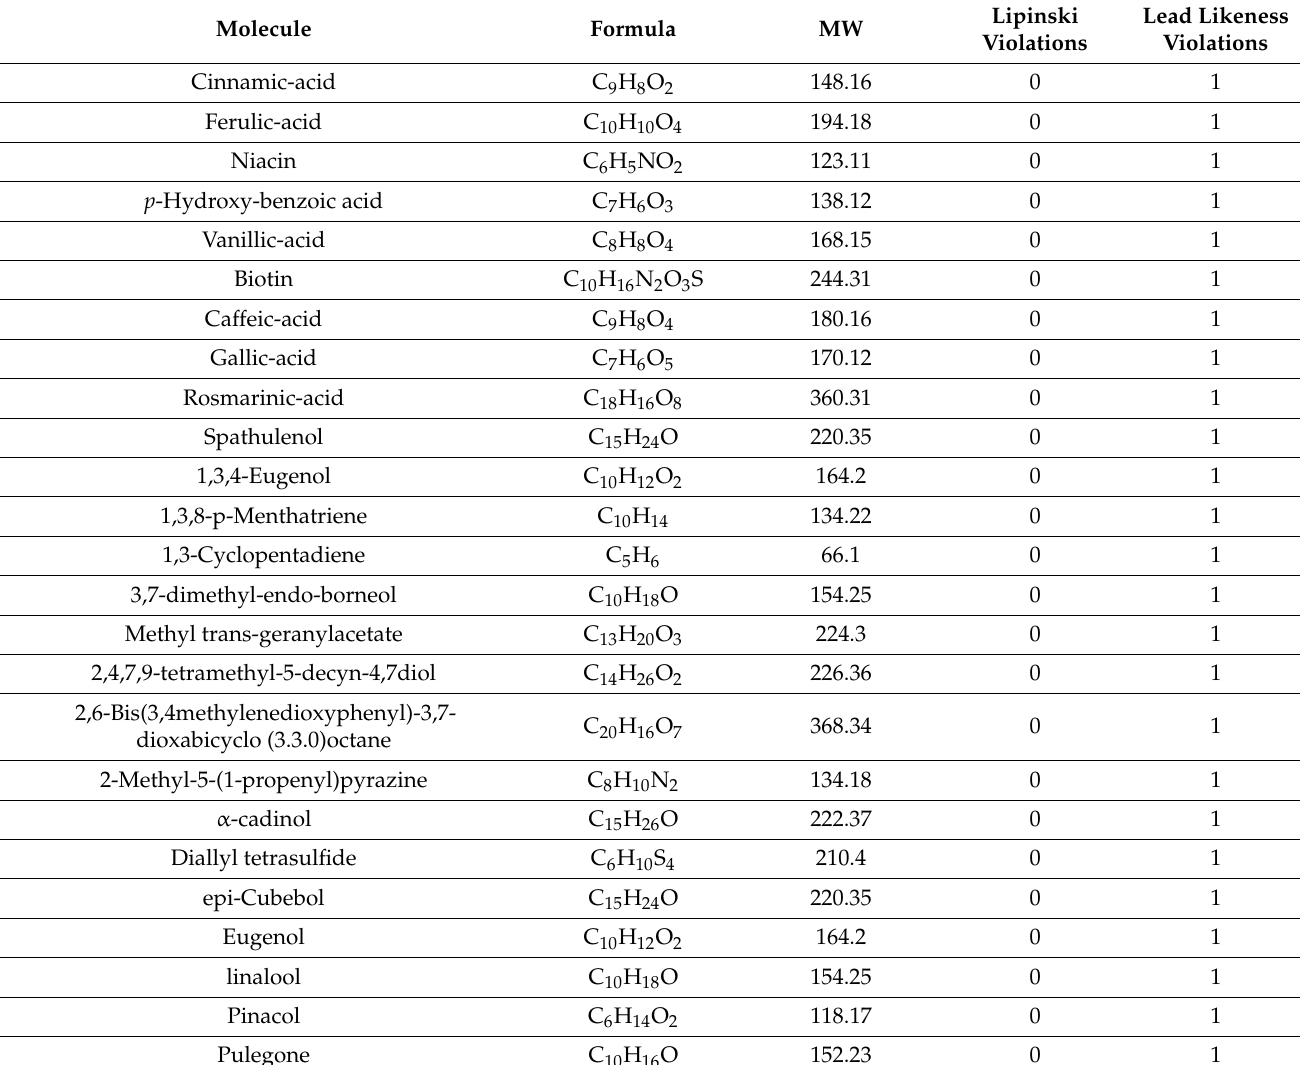
Table 1. Compounds selected through virtual screening (Swiss